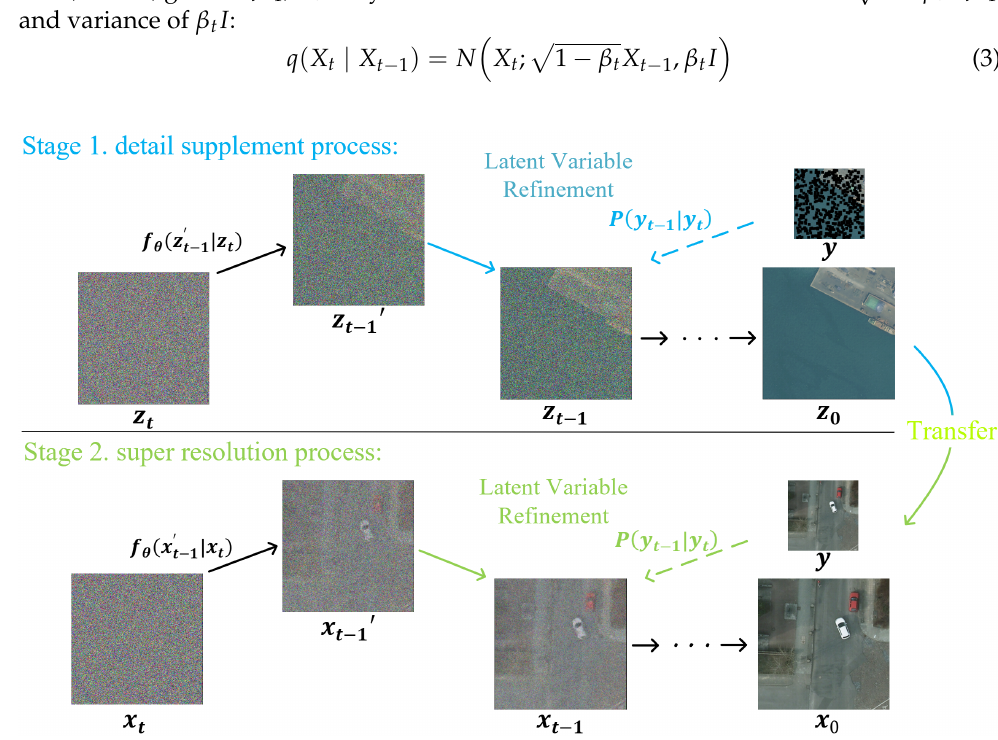
Figure 1. Overview of two stages in DMDC. Stage 1. is the detailed supplementary task process, and stage 2. is the SR reconstruction task process. Starting from the spherical Gaussian noise of the forward diffusion process, the reverse inference process f iteratively denoises the target image z and x according to the source image (from right to left), where y is the